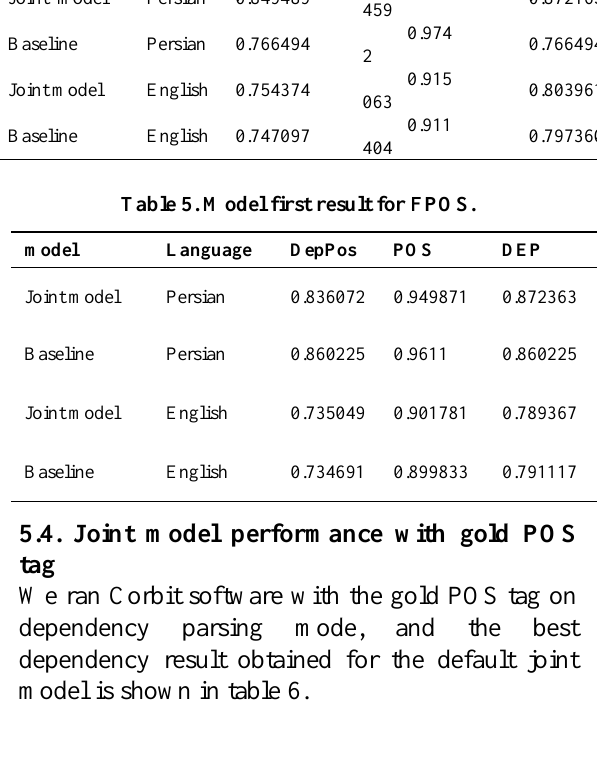
Table 3. Pipeline model results.